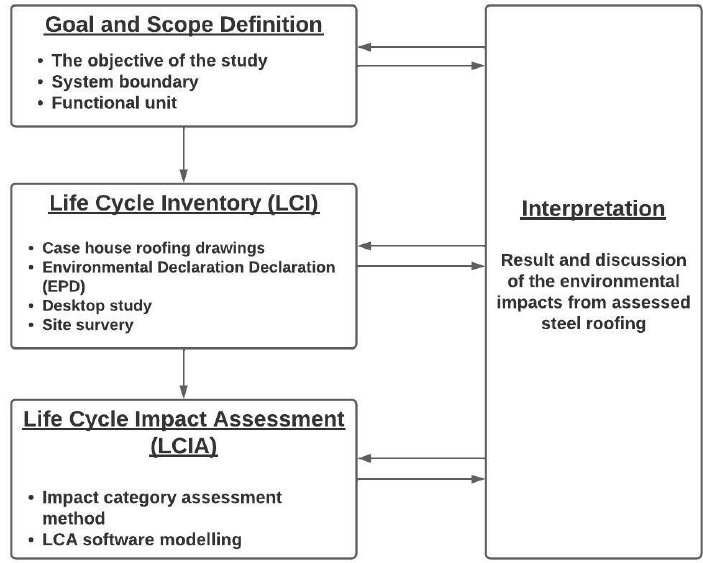
Figure 1. Life cycle assessment framework for the research.